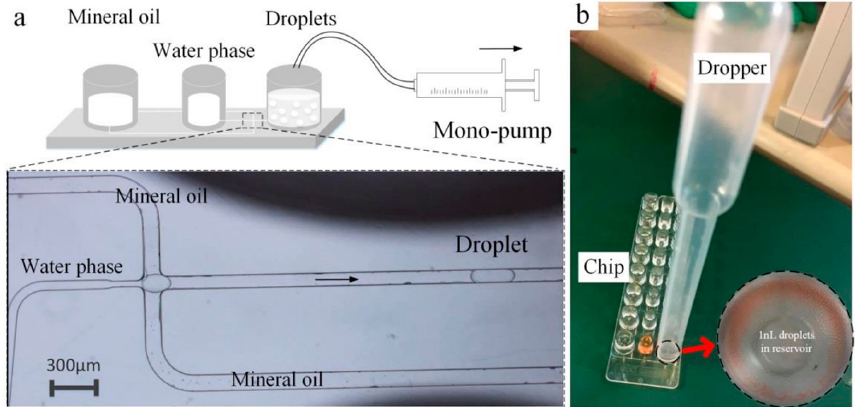
Figure 5. Stability and robustness of droplet size with ranging pump flow rate. ( a ) Shows the assembled droplet generator by the chip of droplet generator from Bio-rad Company, and ( b ) indicates obtained droplets in the reservoir of commercial components within a few seconds of releasing the hand from the dropper.